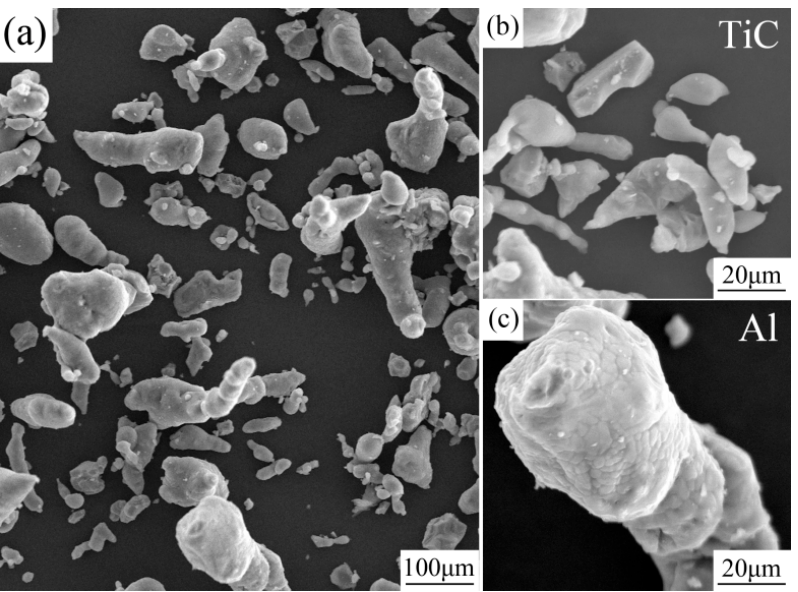
Figure 1. ( a ) Shape of powder particles; ( b ) TiC particle shapes; ( c ) Al particle shapes .